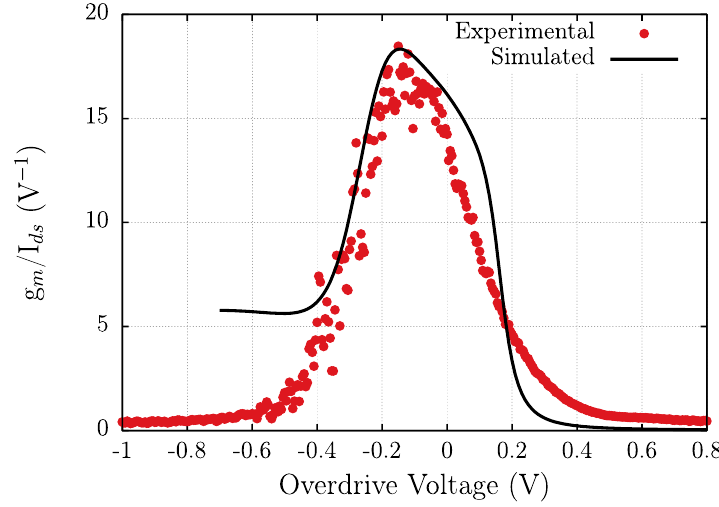
Figure 5. Efficiency of the transconductance vs. the gate overdrive voltage calculated from measurements and numerical TCAD simulations at V ds = 20 mV.